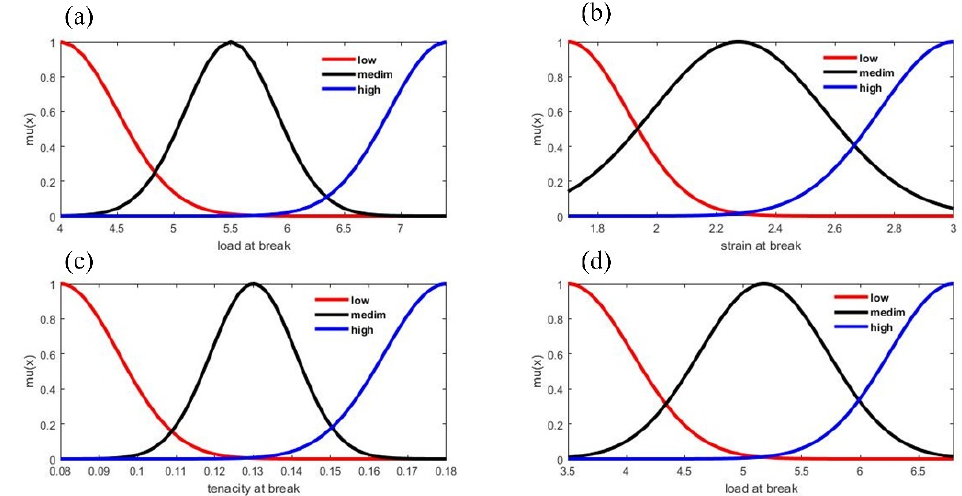
Figure 3. Gaussian membership function for the input parameters; ( a ) load at break, ( b ) strain at break, ( c ) tenacity at break, and ( d ) tensile modulus . Table 2. Fuzzy Inference rules for input and output parameters.